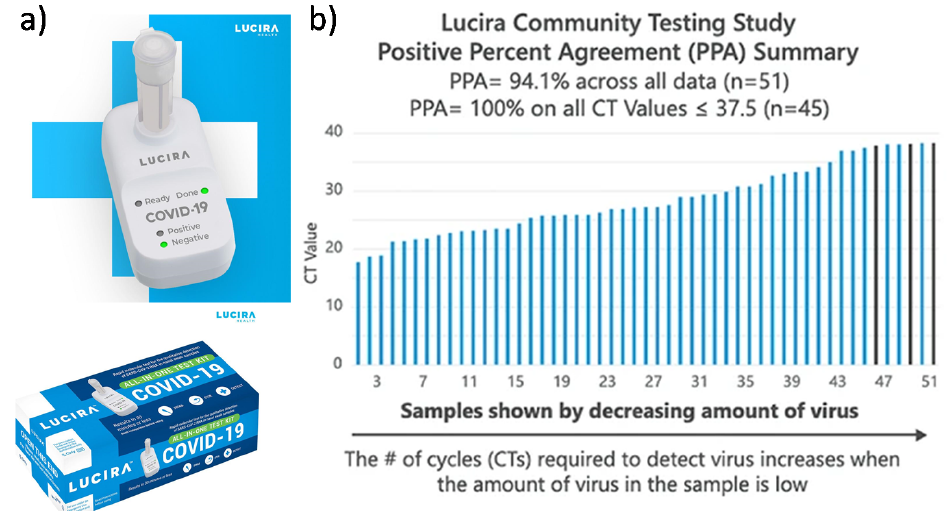
Figure 5. Lucira’s COVID-19 All-In-One Test Kit product and community testing data. ( a ) The single-use, over-the-counter test kit intended for the molecular detection of SARS-CoV-2 RNA from nasal swab samples. ( b ) In a Community Testing Study, the Lucira test was compared with high sensitivity Hologic Panther Fusion SARS-CoV-2 test, and achieved a 94% positive percent agreement (PPA) and a 98% negative percent agreement (NPA). Images are reproduced and adapted with permission from Lucira Health